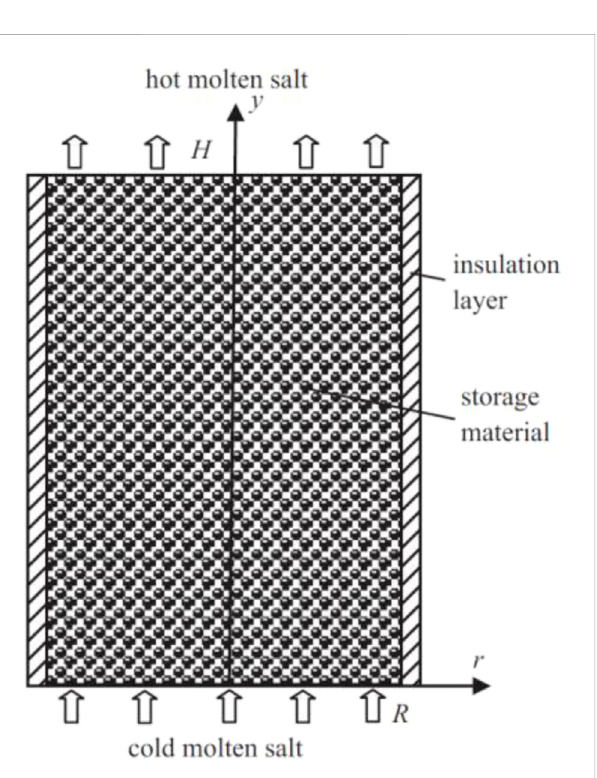
FIGURE 11 Schematic of molten salt thermocline TES (Lu et al., 2015). License Number: